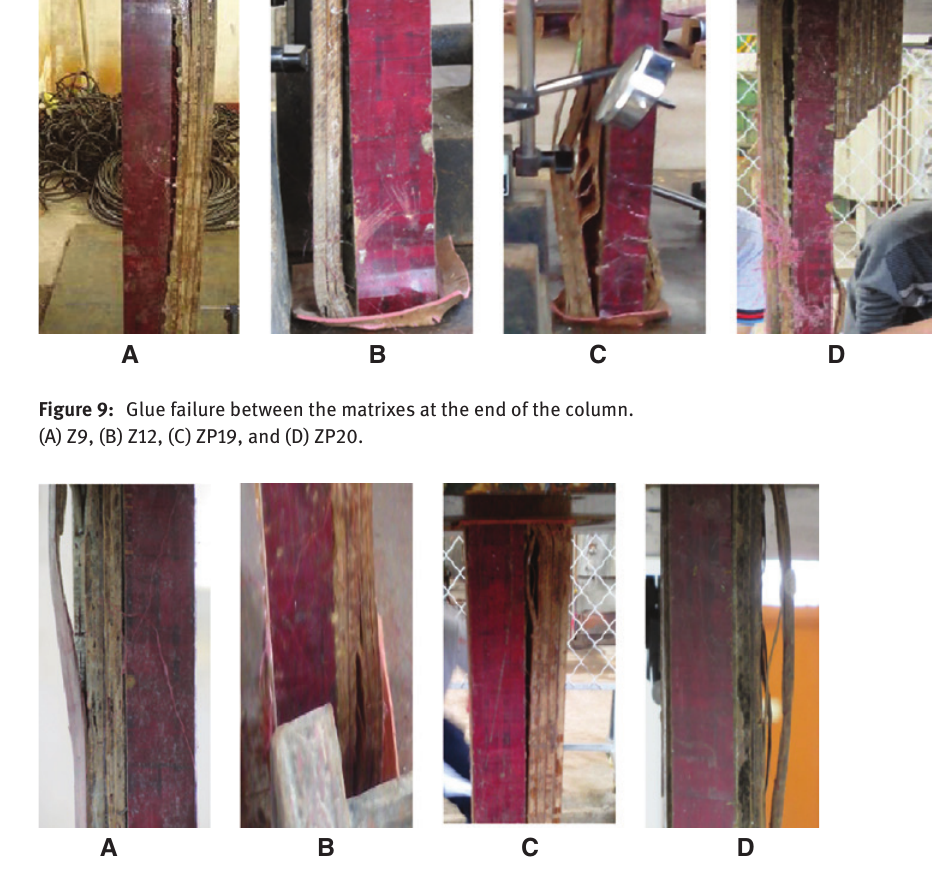
Figure 10: Damage to plywood material at the end of the column. (A) Z3, (B) Z5, (C) Z8, and (D)